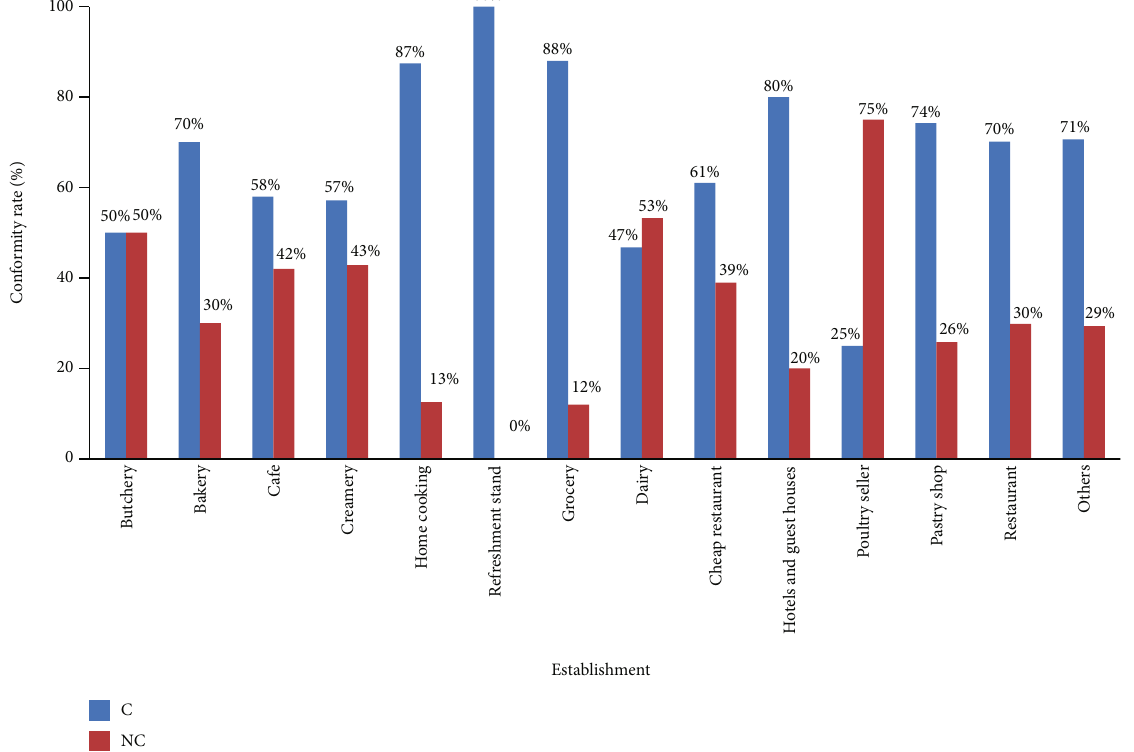
Figure 2: Conformity/non-conformity rate by